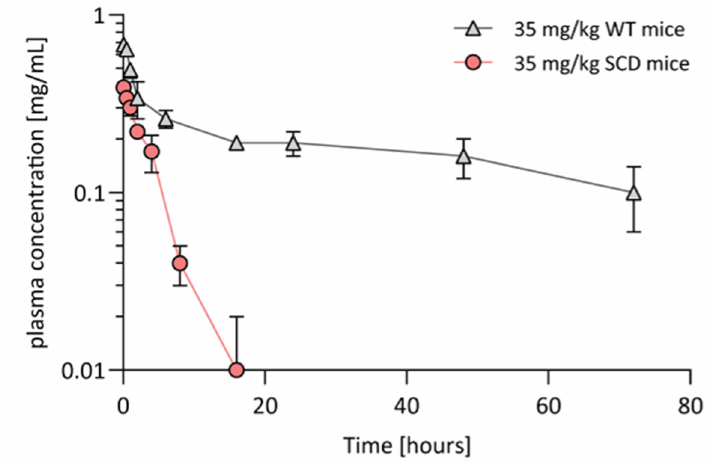
Figure 5. Differences in pharmacokinetics of hemopexin in SCD mice compared to WT mice. Hemopexin plasma concentrations in Townes HbSS and WT mice and rats upon intravenous administration of human hemopexin ( n = 3/time point; 35 mg/kg). Individual data points represent mean concentration values ± SD.